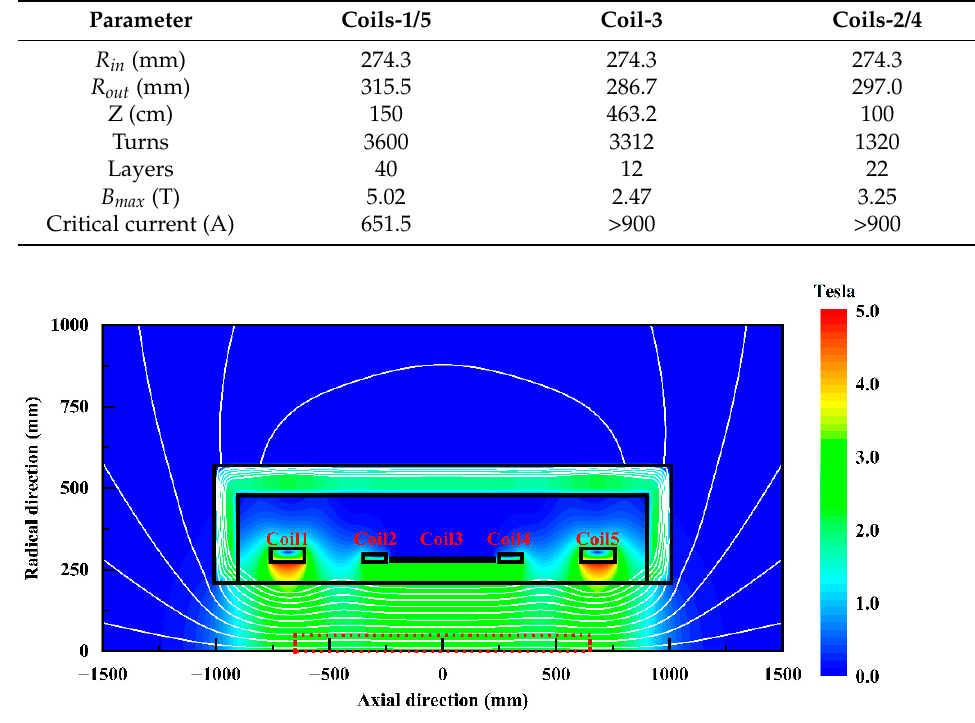
Table 3. Coil Parameters of superconducting magnet subsystem.